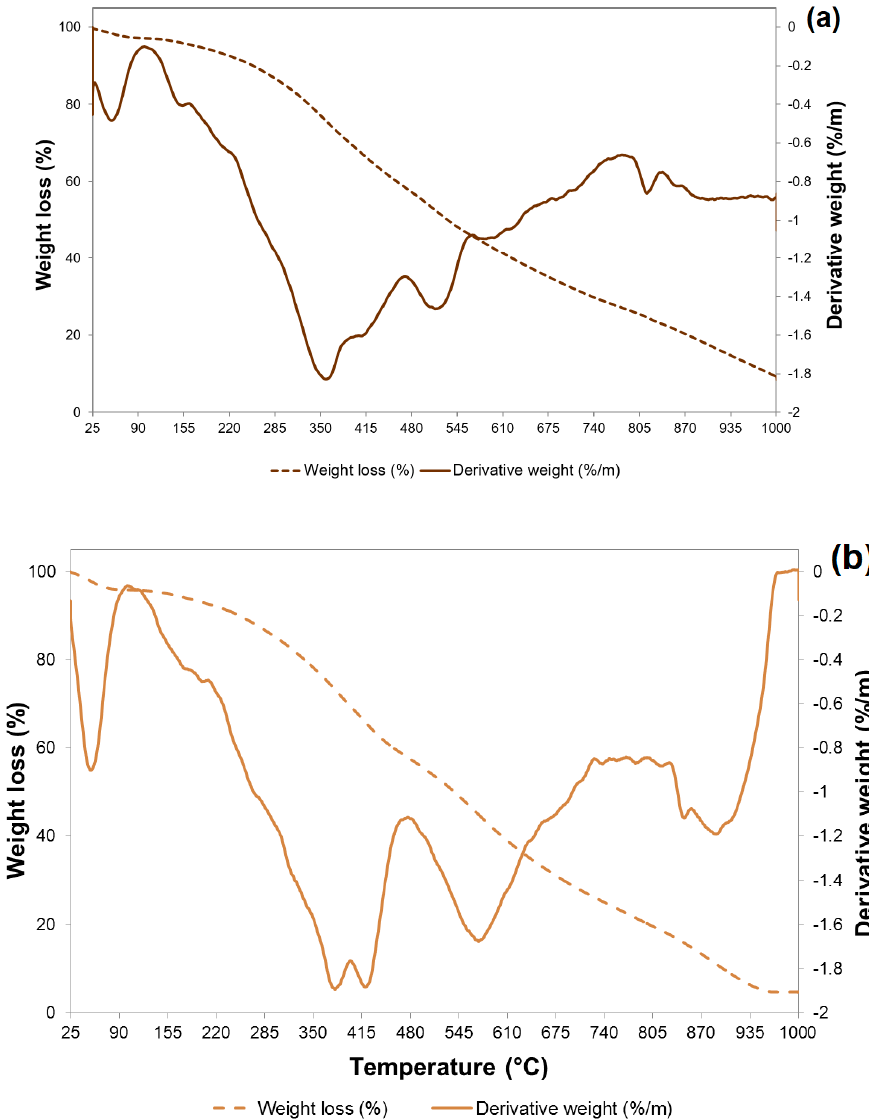
Figure 6. Thermal analysis thermal gravimetric analysis (TGA)/ differential thermal gravimetric (DTG) of ( a ) the lignin and ( b ) lignin + PVP samples.